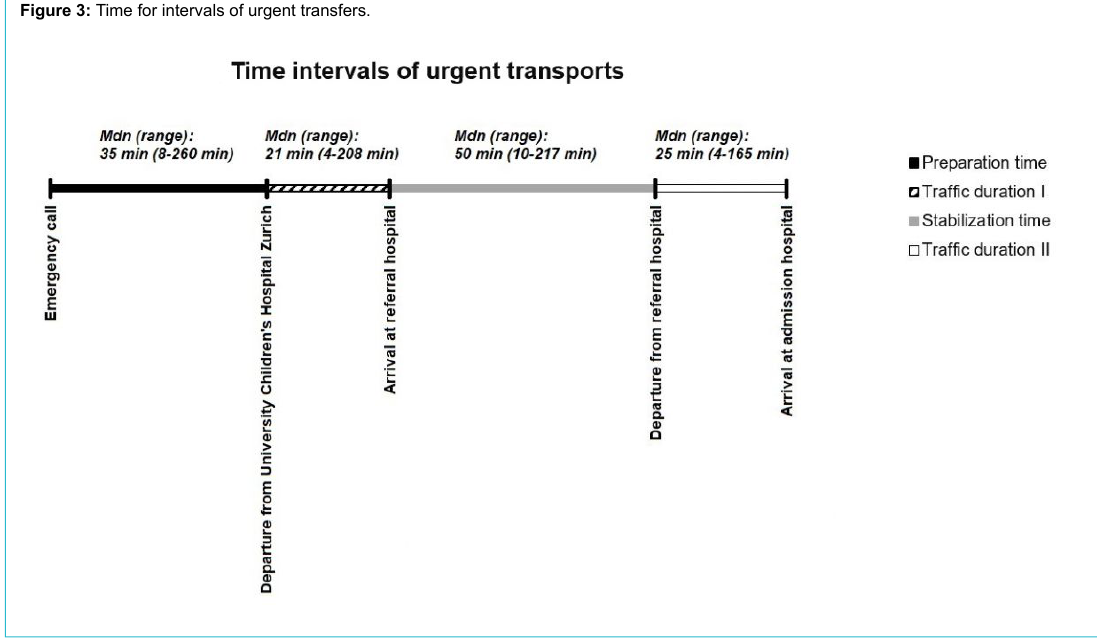
Figure 3: Time for intervals of urgent transfers.